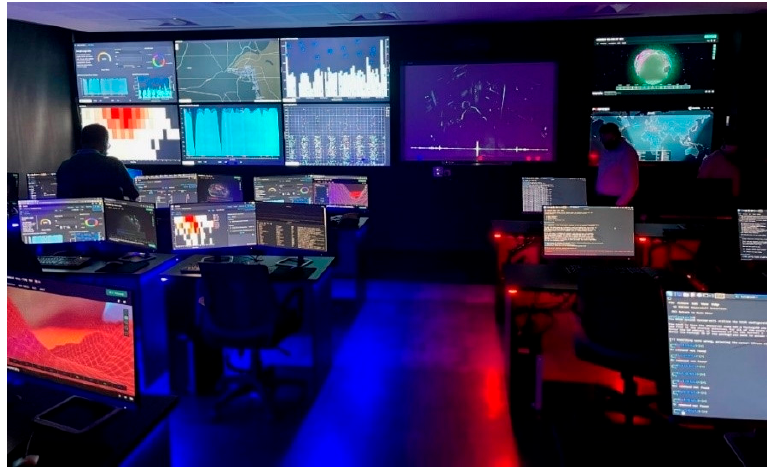
Figure 4. The cyber-security lab developed for practically implementing the project.